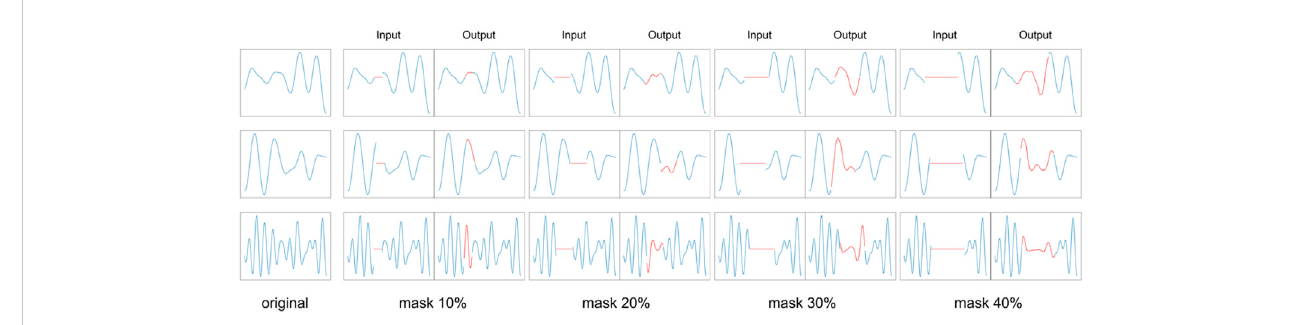
FIGURE 4 Reconstructions of the test synthetic seismic signals.